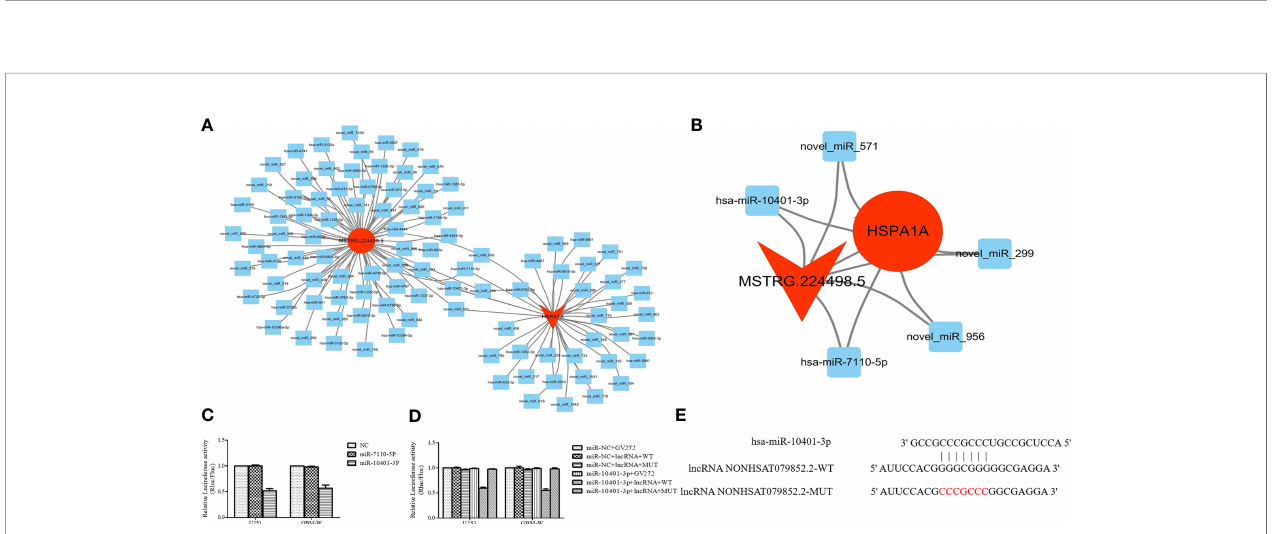
FIGURE 6 | LncRNAs NONHSAT079852.2 Functions as a ceRNA for has-mir-10401-3p to facilitate HSPA1A Expression. (A) miRNA targeting HSPA1A and lncRNA NONHSAT079852.2, respectively. (B) Co-targeting miRNAs of HSPA1A- lncRNA NONHSAT079852.2; LncRNAs is represented by a circle, miRNA is represented by a diamond, mRNA is represented by an arrow, The up-regulated expression gene is indicated by red, and the gene without signi fi cant change is indicated by blue. (C) Relative luciferase activity in U251 and GBM-W cells co-transfected with lncRNA MSTRG224498.5 reporter plasmid and candidate miRNAs. (D) Relative luciferase activity in glioma cells transfected with wild-type lncRNA NONHSAT079852.2 vector, mutant-type vector or empty vector. (E) has-mir-10401- 3p and lncRNA NONHSAT079852.2 binding sequences and lncRNA NONHSAT079852.2 mutation